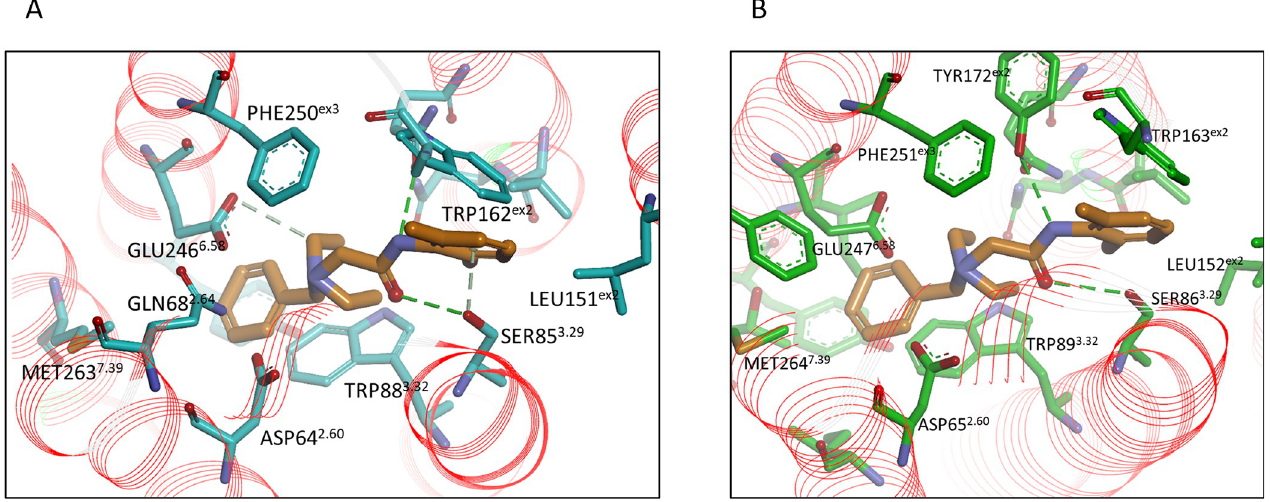
Fig 3. In silico models of DB binding with hTAS2R10 and the dog/human chimeric receptor Chimera1. A) hTAS2R10 residues are shown in blue, DB is in brown. B) Chimera1 residues are shown in green. Amino acids adjacent to DB are almost identical in the two receptors.